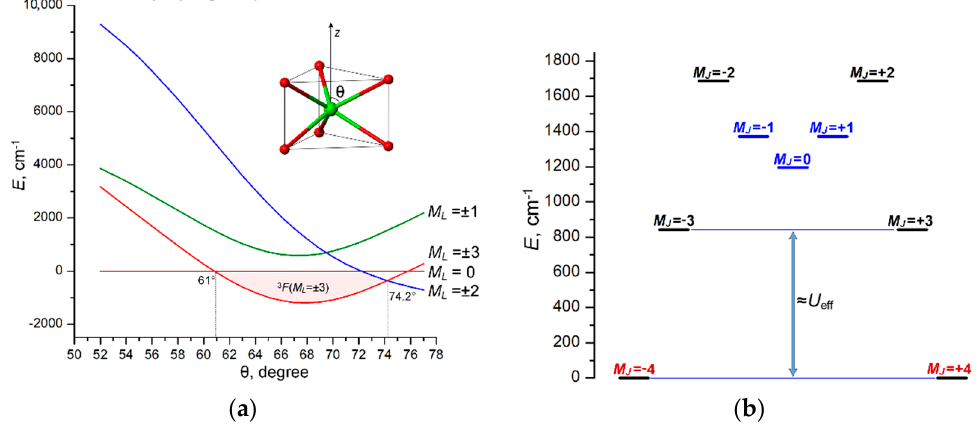
Figure 7. ( a ) Variation of the energies of the 3 F ( M L ) LF states of Ni 2+ (3d 8 ) ion with increasing polar angle θ in trigonal-prismatic coordination, as obtained from LF/AOM calculations. The range of the stabilization of the 3 F ( M L = ±3) ground state (61° ≤ θ ≤ 74.2°) is marked with light pink; ( b ) E vs. M J diagram calculated at θ = 64°. The spin-reversal barrier U eff ≈ 850 cm − 1 is approximately estimated by the energy separation between the ground M J = ±3/2 and the first excited M J = ±5/2 states; the M J = 0 and M J = ±1 states (marked in blue) originate from 2S+1 L atomic terms other than 3 F . LF/AOM calculations were performed with e σ = 5000 cm − 1 , e σ / e π = 4 AOM parameters and atomic parameters B = 800, C = 3200 and ζ = 600 cm − 1 .